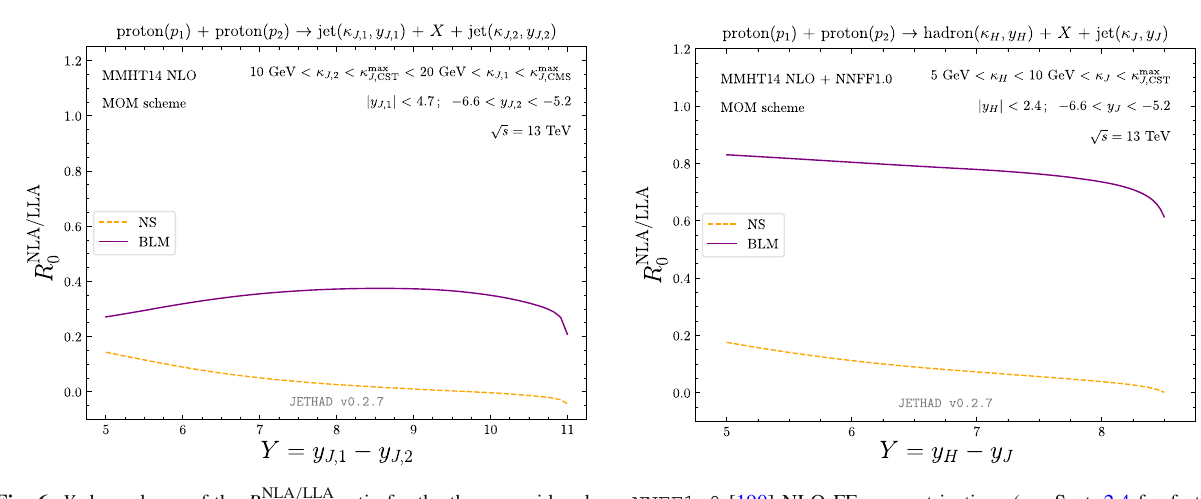
Fig. 5 Y -dependence of the R NLA reactions(Fig.2)inthe asymmetricCMS configurationandfor TeV. Hadron emissions, when considered, are described in terms of